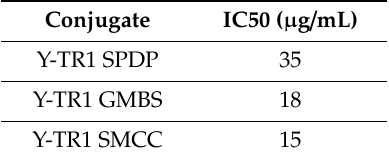
Table 2. Comparison of IC50 of Y-TR1 using various linkers (SPDP, GMBS, SMCC).